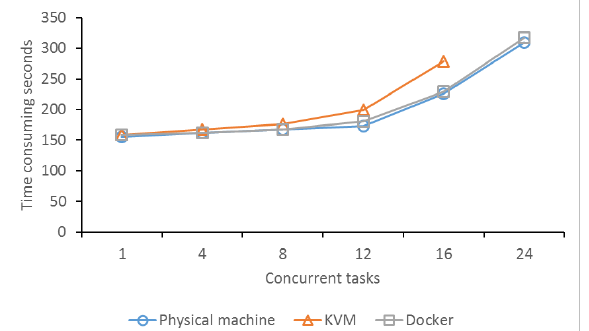
Figure 8. Average execution time of different concurrent tasks